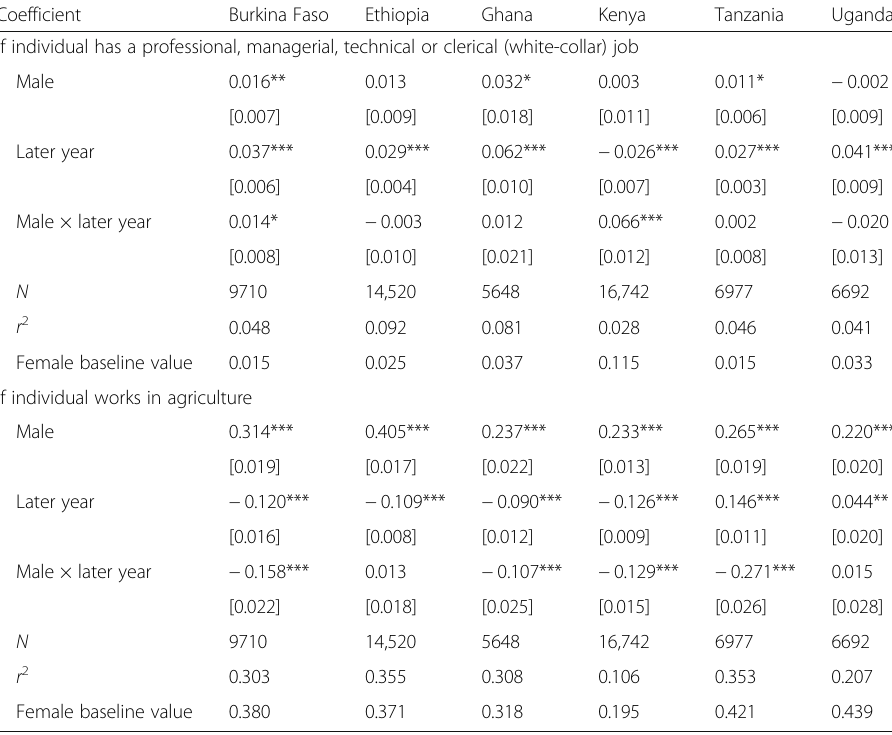
Table 7 Regressions for job outcomes based on pooled country-level data Coefficient Burkina Faso Ethiopia Ghana Kenya Tanzania